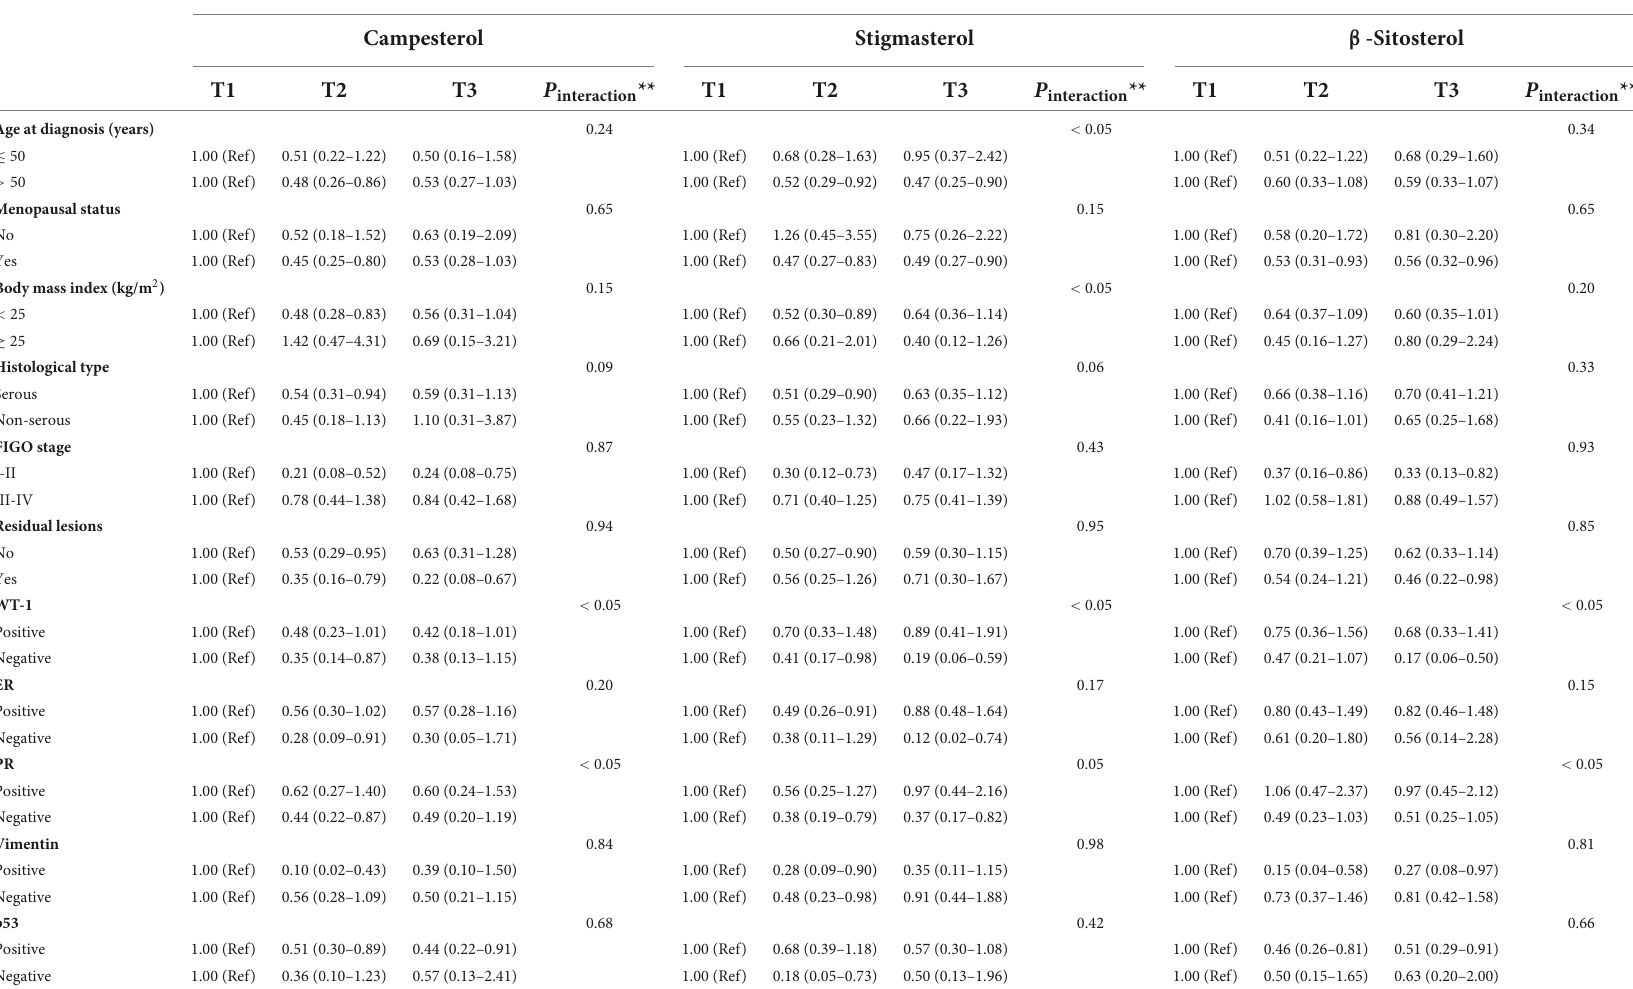
TABLE 4 Subgroup analyses of demographical, clinical, and immunohistochemical characteristics for adjusted hazard ratio (HR) and 95% confidence interval (CI) for the associations of campesterol, stigmasterol, and β -sitosterol intake with overall survival among ovarian cancer